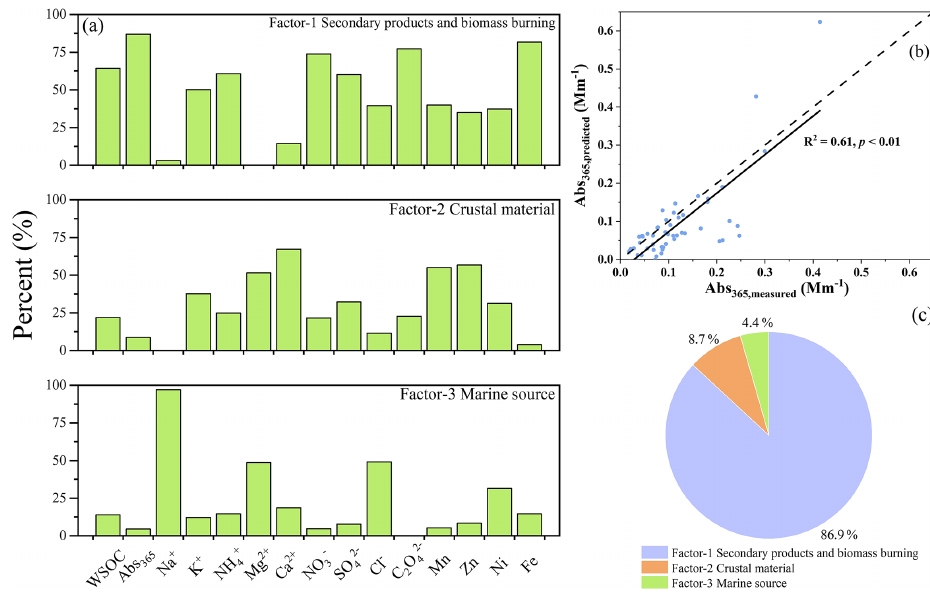
Figure 4. (a) The composition profiles (% of each species) for the three factors simulated of cloud water by PMF, and (b) the correlation of measured, and predicated Abs 365 , and (c) the source apportionment for Abs 365 in cloud water.